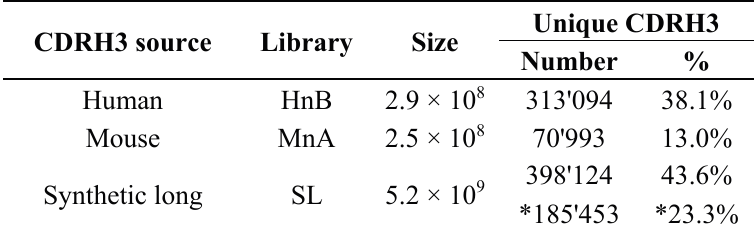
Table 1. Description of the libraries used in selections against horseradish peroxidase (HRP). The diversity is defined as the number of unique sequences observed analyzing a pool of one million random sequences per library. For the synthetic library, numbers marked “*” correspond to the number of unique sequences which fit the theoretical